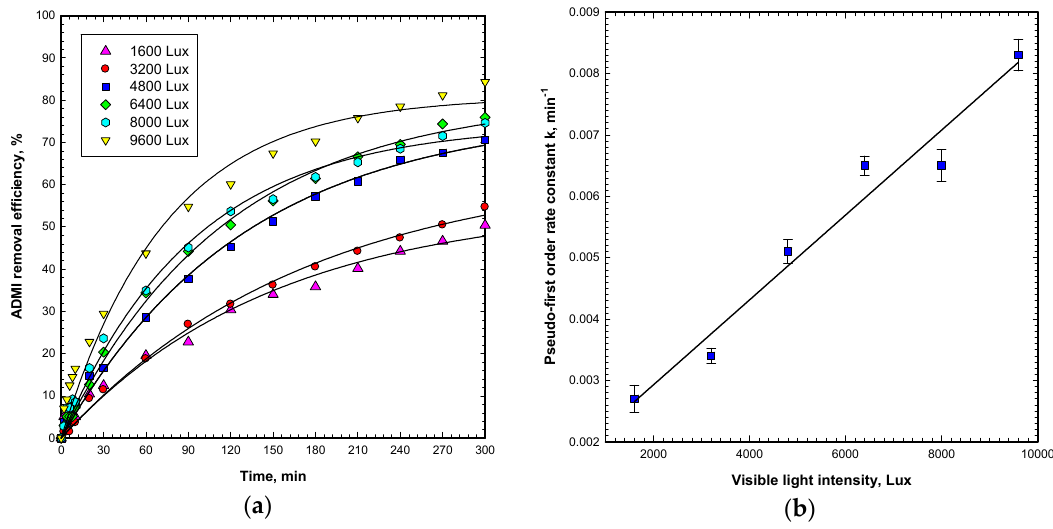
Figure 5. Effect of visible light intensity on ( a ) OG degradation and ( b ) the first-order rate constant, by the Vis/ZnO process. The operating conditions were: initial OG concentration of 50 mg L − 1 , ZnO dosage of 60 g m − 2 , Visible light intensity of 1600–9600 Lux, and reaction time duration of 300 min.